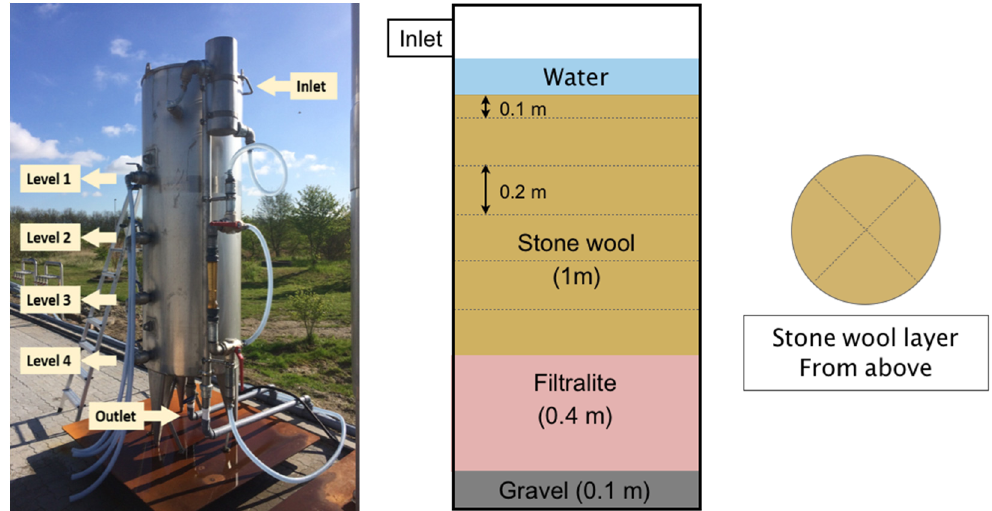
Figure 1. Overview of the biofilter. The effluent water from the treatment plant entered at the top ( inlet ), and was discharged at the bottom ( outlet ).